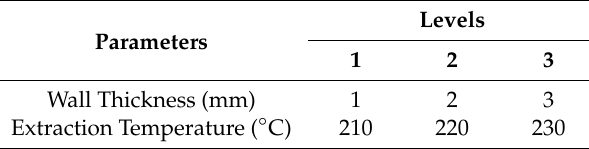
Table 1. Selected FDM process parameters and their levels.